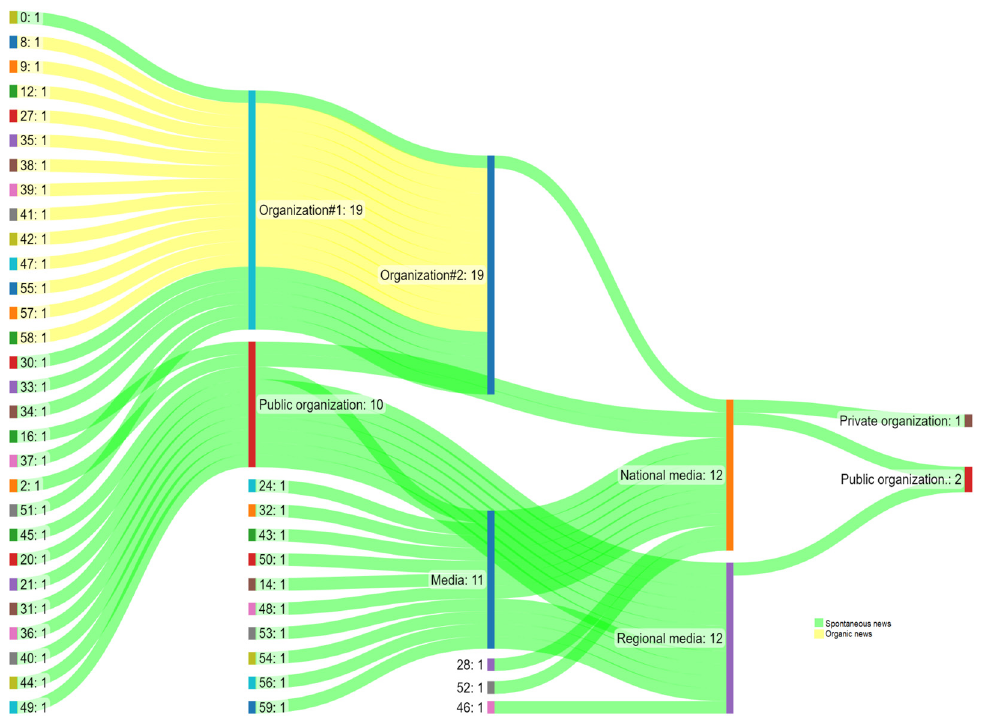
Figure 5. Scheduling processes between media (intermedia), between media and organizations, and between organizations (inter ‐ organization).